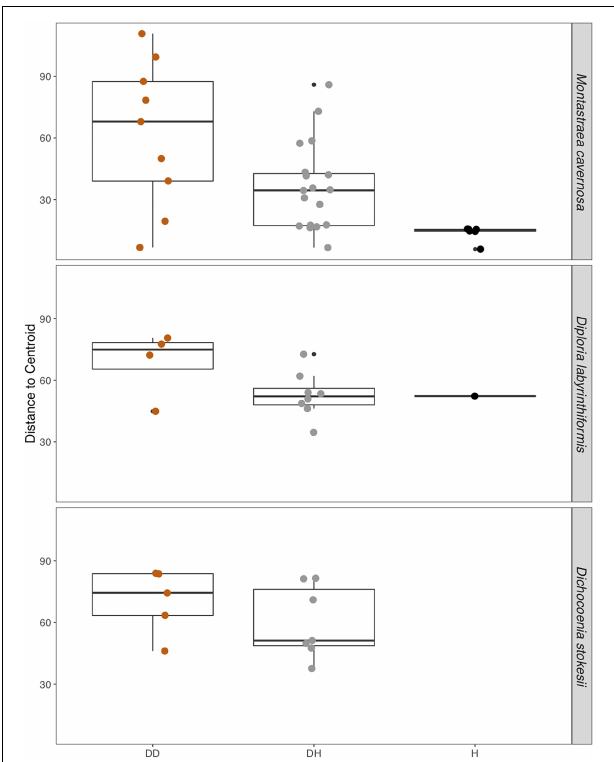
FIGURE 4 | The dispersion of beta diversity shown as the distance to the centroid in microbial communities from disease lesions (DD), apparently healthy tissue on diseased corals (DH), and apparently healthy neighboring corals with no signs of disease (H) in Montastraea cavernosa , Diploria labyrinthiformis , and Dichocoenia stokesii